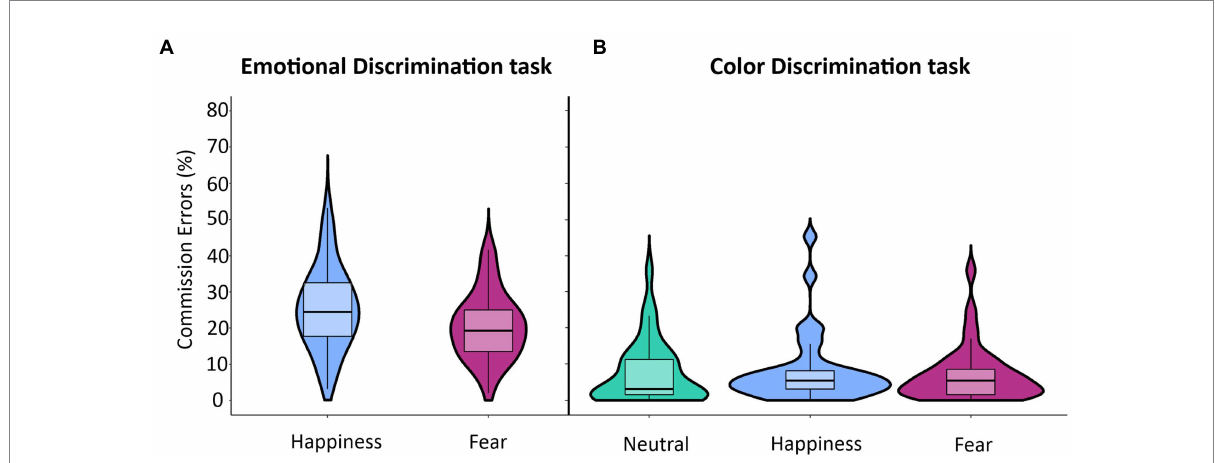
FIGURE 4 Effects of emotional body postures on average commission errors in the Emotional and Color Discrimination tasks. In the Emotional Discrimination task (A) , the rate of commission errors was significantly higher for happy than for fearful body postures (see Table 1 for statistics). Differently, in the Color Discrimination task (B) , there were no differences in the rates of commission errors between any of the three types of body postures. The violin plots depict kernel probability density, i.e., the width of the areas represents the relative frequency of the data. Box plots are shown inside the violin plots. The lower box’s boundary indicates the first quartile, the median is marked with a black line.